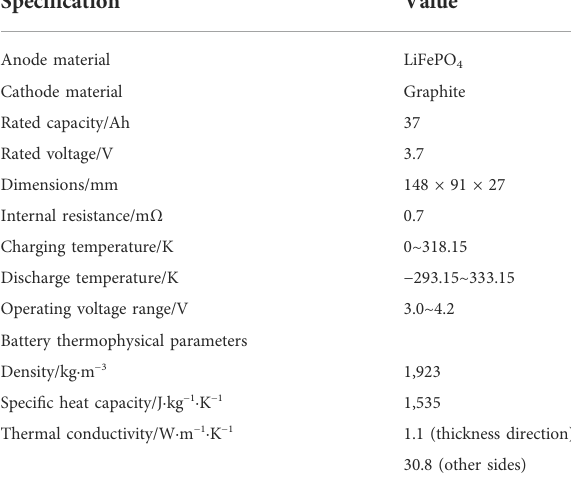
TABLE 2 Parameters of lithium-ion